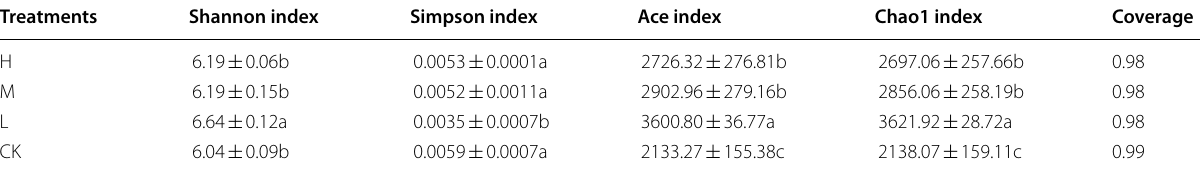
All data are presented as the mean SD (standard deviation) ± H high N application in the sugarcane soil (964 kg ha − 1 ), M medium N application in the sugarcane soil (482 kg ha − 1 ), L low N application in the sugarcane soil (96 kg ha − 1 ), CK no N application in the sugarcane soil (0 kg ha − 1 ) Different letters in the same column indicate significant differences between treatments at P < 0.05 among the means of the four